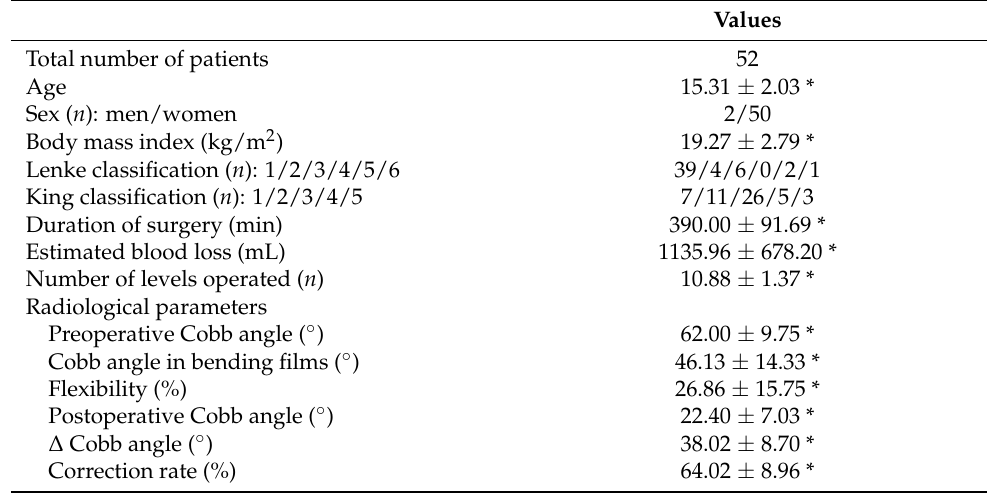
Table 1. Baseline characteristics and outcomes of the patients who underwent minimally invasive scoliosis